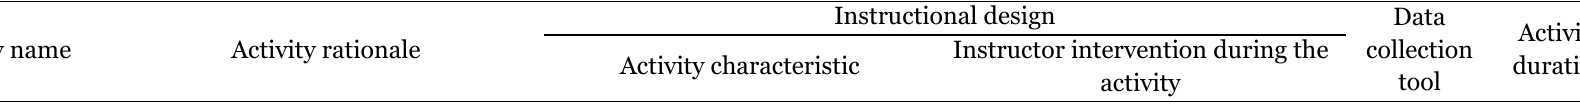
The TPD Program Design – The Seven Assignments, Their Rationale Characteristics and Duration, the Interventions, and the Data Collection